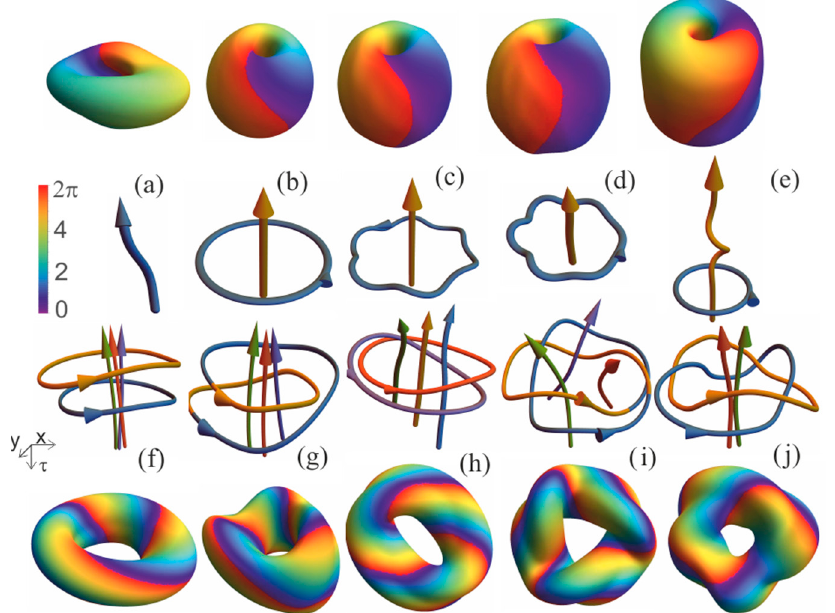
Figure 11. The upper and lower rows: isointensity surfaces of tangle laser solitons at intensity level 0.5 I max . Two middle rows: Skeletons of the solitons–arrays of their vortex lines. The number of unclosed vortex lines is one ( a – e ), two ( j ) and three ( f – i ). Unclosed lines ( a ) are absent, “precesson”, ( b )–( e )—one unknotted closed, “apples”, ( f )—two knotless unlinked, ( g )—one, trivial knot, ( h )—two unknotted, a single Hopf link, ( i )—one knotted, a trefoil knot, ( j )—two unknotted, with a double link, “Solomon link”. The torsion index of the closed lines s = 0 ( b – f ), —1 ( g ), —2 ( h ), —3 ( i ), —4 ( j ). The arrows on the vortex lines indicate the direction of the increasing phase of the radiation ( m = 1 ).